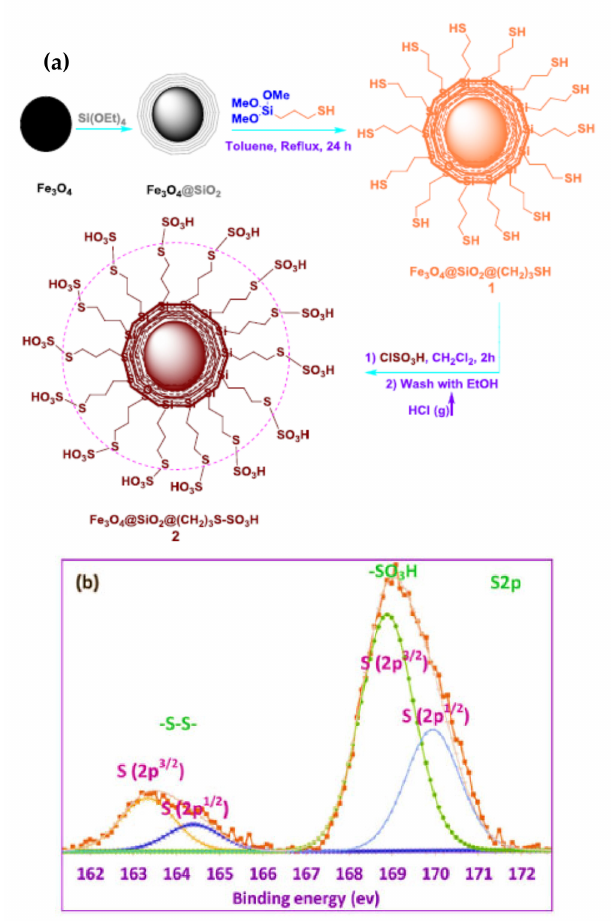
Figure 20. Scheme from ref [38]. Synthesis of magnetic nanocatalysts Fe 3 O 4 SiO 2 (CH 2 ) 3 S-SO 3 H ( a ) and S2p XPS region ( b ). Reprinted with permission from ref. [38]. Copyright 2017 John Wiley and